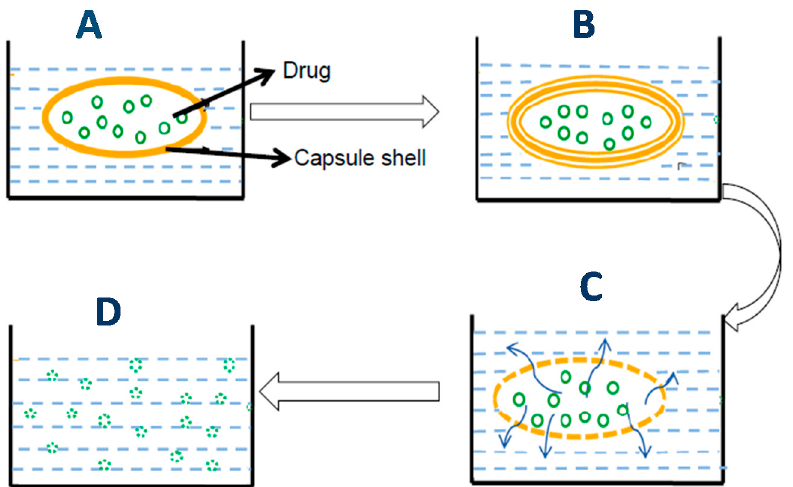
Figure 6. A schematic diagram showing different stages of drug dissolution from SGCs. ( A ) The initial state of the SGC, ( B ) swelling of the SGC shell, ( C ) rupture of the SGC shell to release the fill materials, ( D ) dispersion and dissolution of the drug in the dissolution medium. Reproduced with permission from [63], Dissolution Technol., 2006.